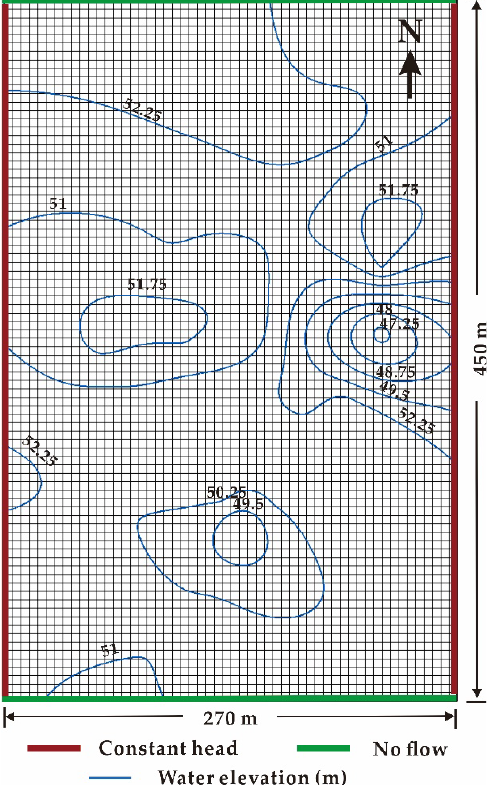
Figure 3. Discretization using a regular grid.